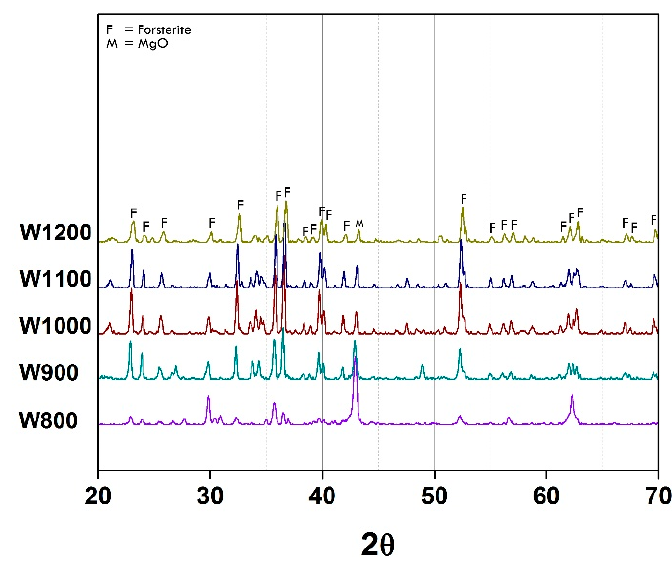
Figure 2. XRD patterns of as-calcined forsterite powder from mirror waste at various temperatures between 800 and 1200 °C.